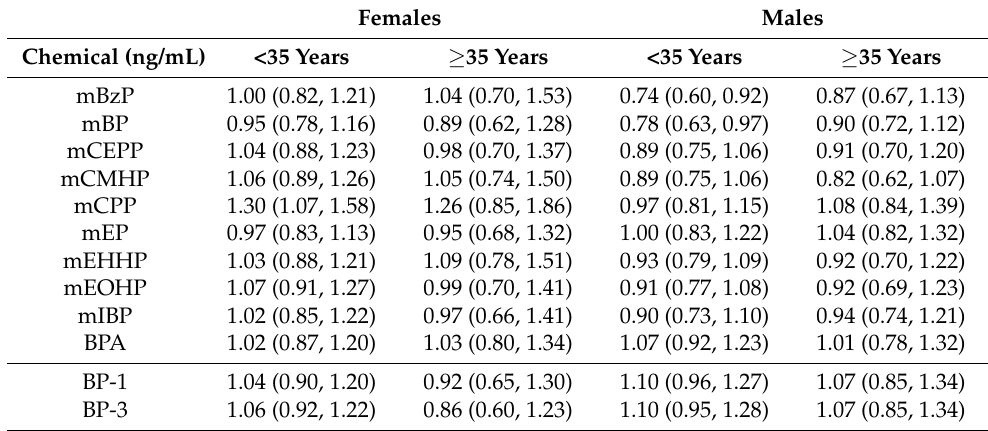
Table 3. Fecundability odds ratios (FORs) for urinary phthalate metabolites, bisphenol A, and benzophenone-type ultraviolet filters by age (<35 to age ≥ 35 years) among participants in the Longitudinal Investigation on Fertility and Environment Study in Michigan and Texas